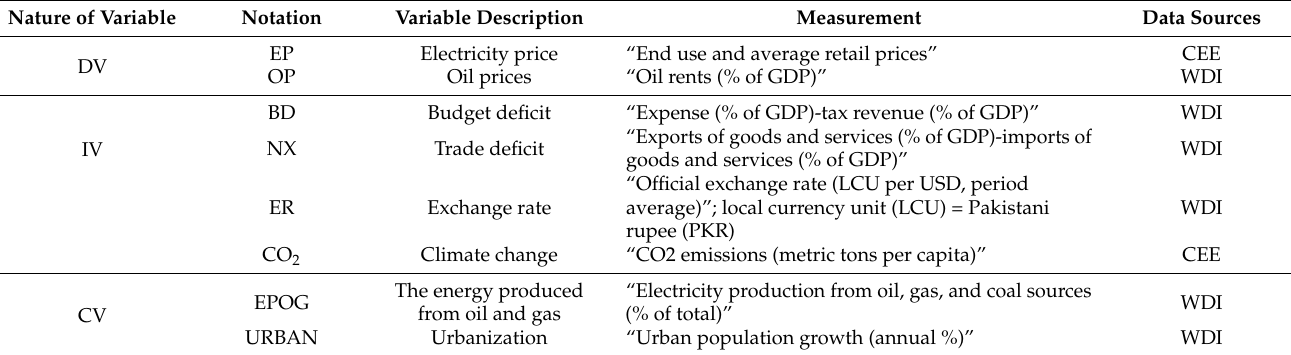
Table 1. Variables, description, measurement and data